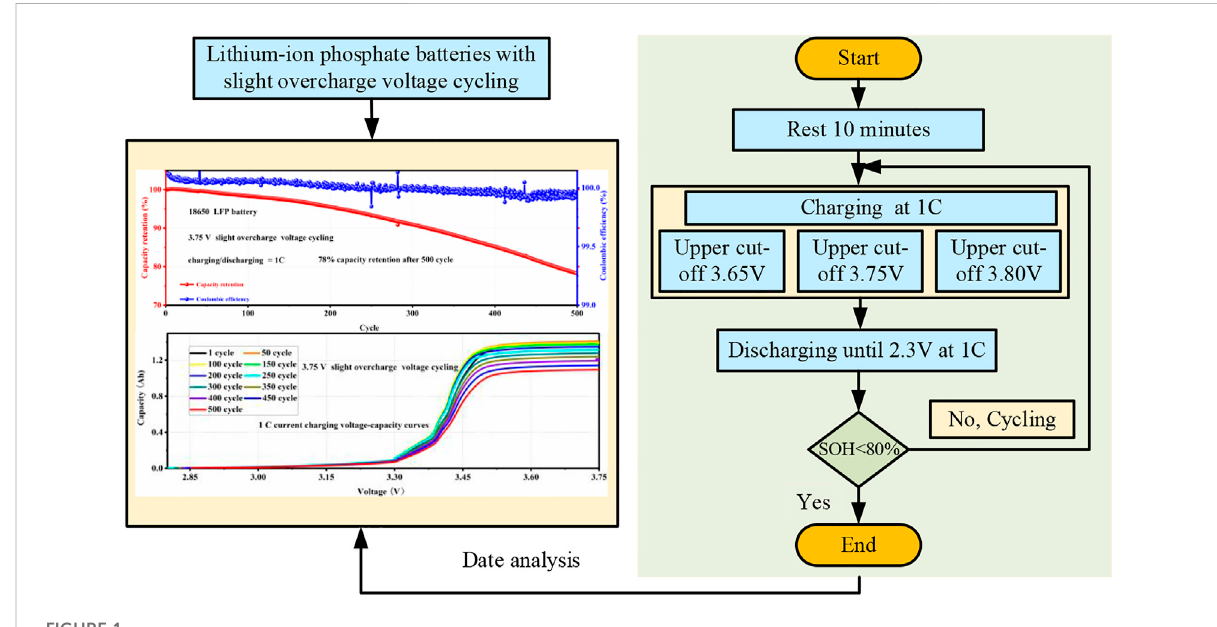
FIGURE 1 Speci fi c test fl ow under slight